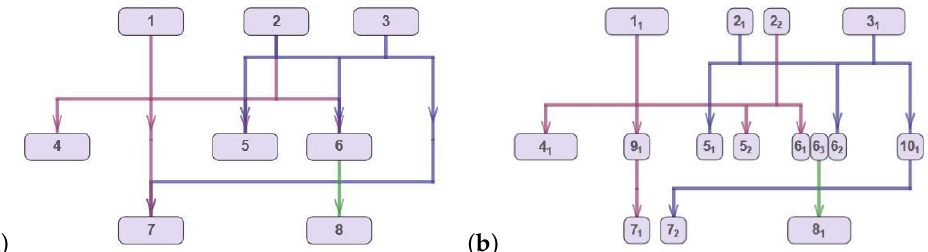
Figure 7. Transformation of hypergraph H into hypergraph H (cid:48) : ( a ) original hypergraph H ; ( b ) hyper- graph H (cid:48) obtained after inserting dummy vertices and port vertices.